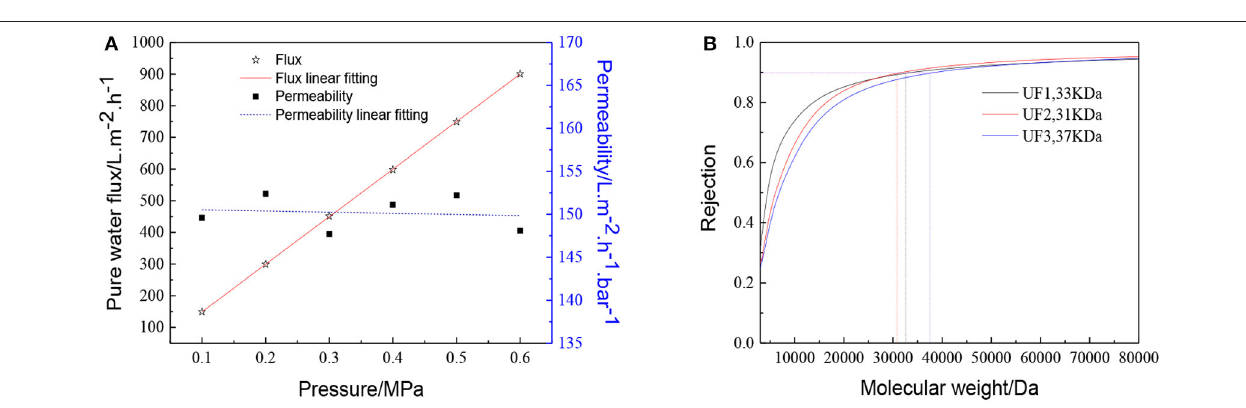
FIGURE 10 | Performance of the ZrO 2 ultrafiltration membrane: (A) Pure water flux and permeability (B) Dextran retention